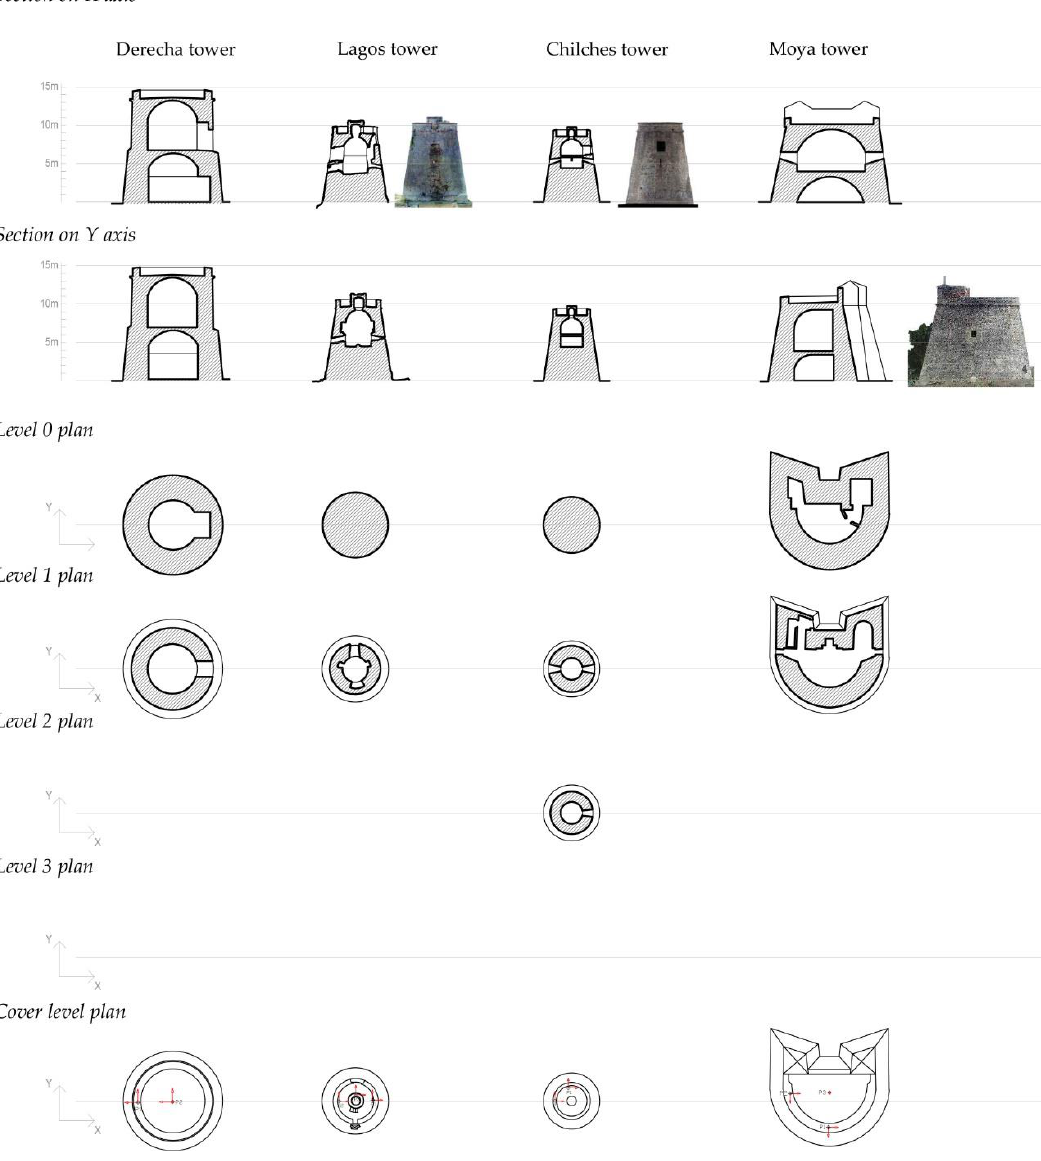
Figure 5. Description of elevations and plans of towers in this study .